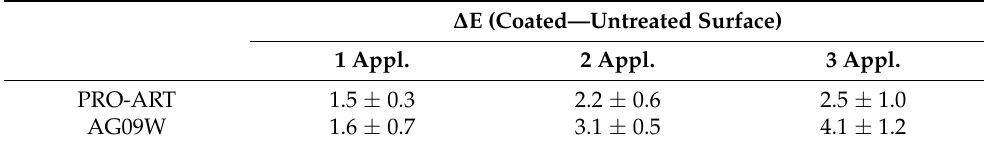
Figure 4. Absorbance over time detected on samples uncoated and coated with PRO-ART.